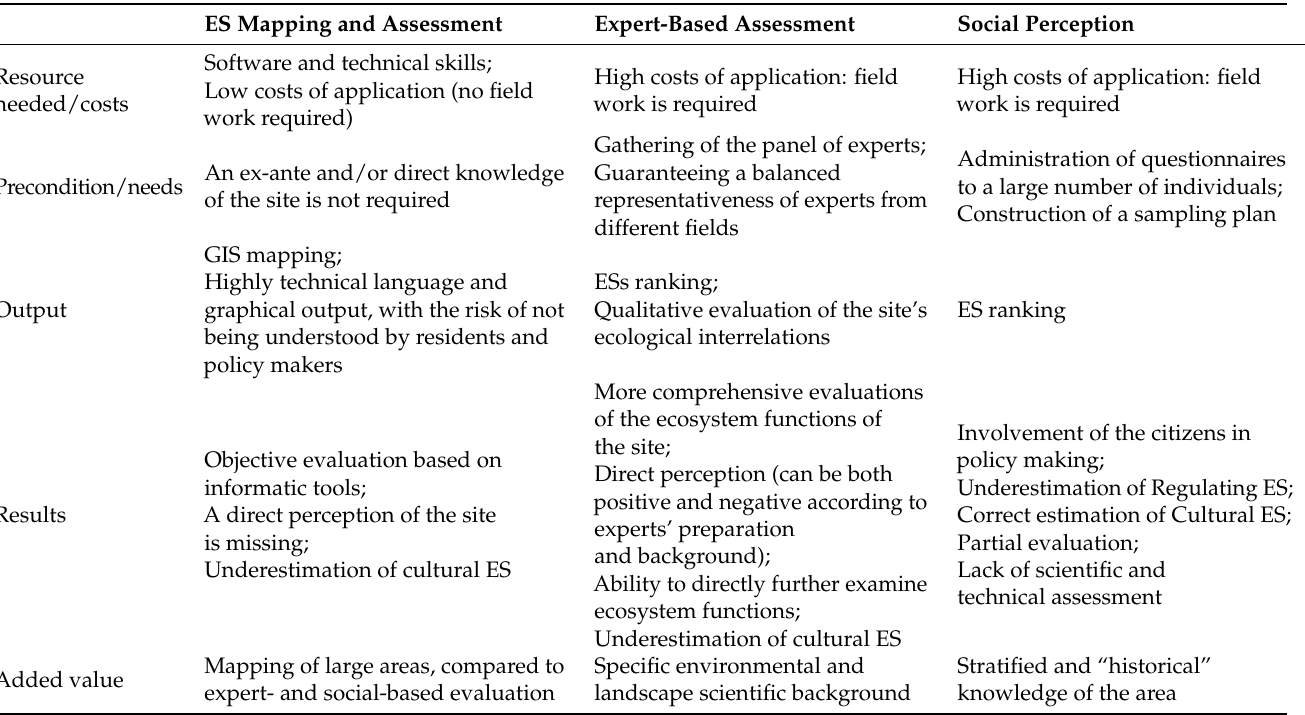
Table 2. Analysis of ES evaluation methods. The columns represent the three methodologies tested, and the rows identify the domains that were chosen for their transversal